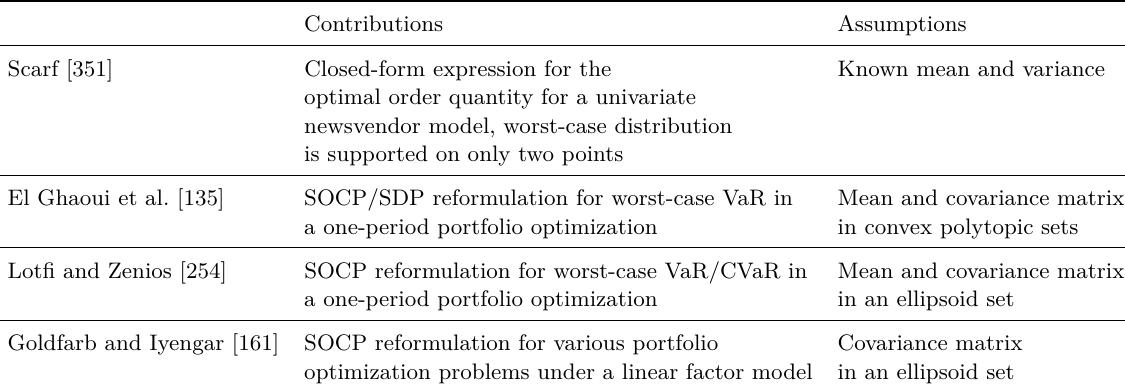
Table 4 Contributions for Chebyshev-based ambiguity sets Contributions Assumptions Scarf [351] Closed-form expression for the optimal order quantity for a univariate newsvendor model, worst-case distribution is supported on only two points SOCP/SDP reformulation for worst-case VaR in a one-period portfolio optimization Lotfi and Zenios [254] SOCP reformulation for worst-case VaR/CVaR in a one-period portfolio optimization